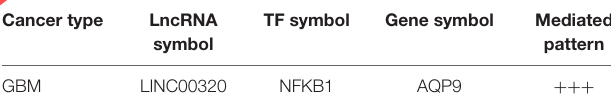
LINC00320 was downregulated, but AQP9 was upregulated in glioma tissues.